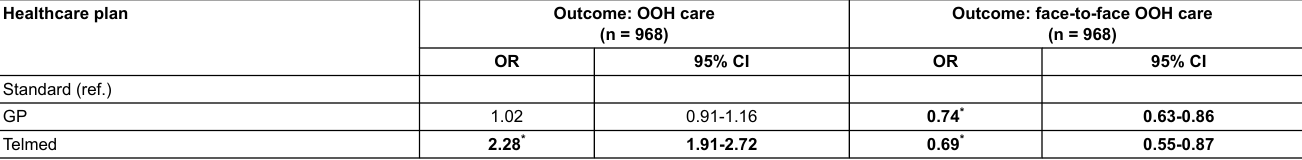
Table 4: Binomial regression analyses for impact of healthcare plan on (face-to-face) out-of-hours help-seeking. Healthcare plan